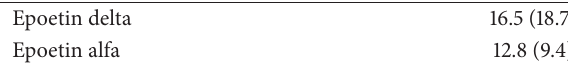
Table 1: Patient demographics and baseline characteristics at study entry (safety population, 𝑛 = 279 ).